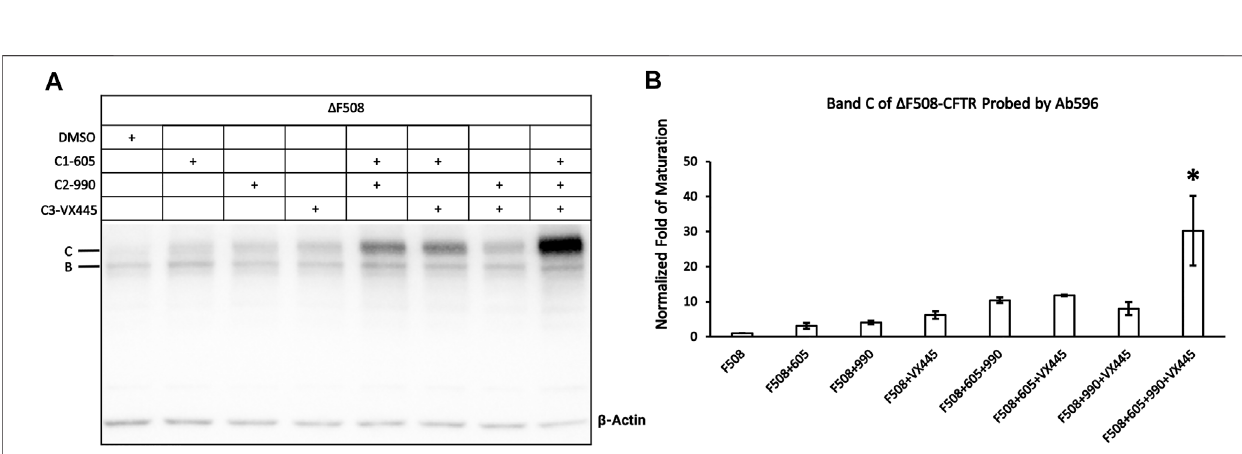
Frontiers in Molecular Biosciences |